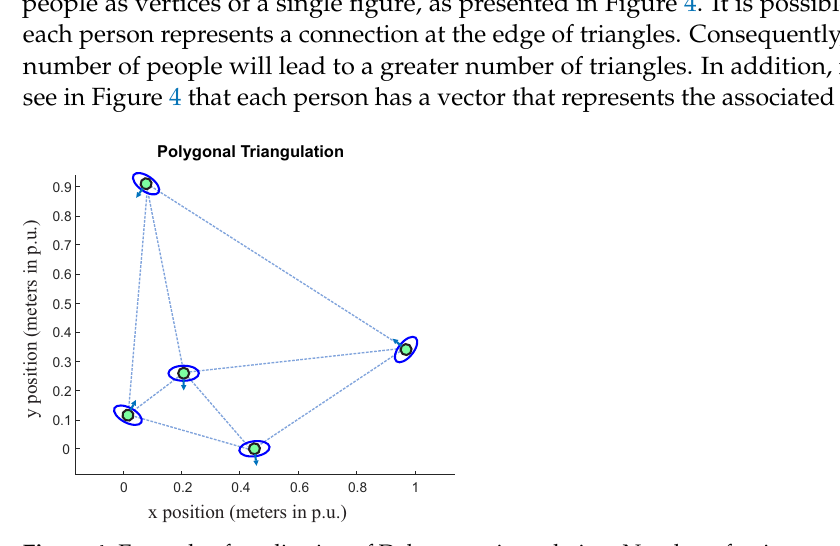
Figure 4. Example of application of Delaunay triangulation. Number of points n =